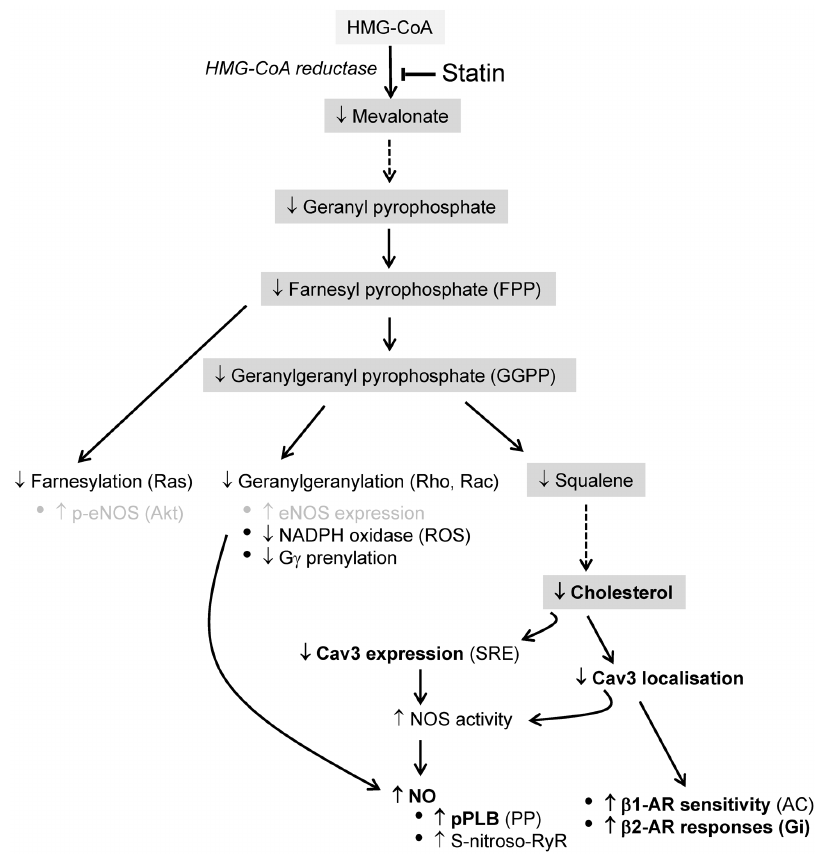
Figure 10. Statin effects on the cardiac myocyte. The main cholesterol synthesis pathway is highlighted in grey. The impact of statin inhibition of HMG-CoA reductase, the rate limiting step of cholesterol synthesis, is shown. Statins limit production of cholesterol and isoprenoid intermediates (FPP, GGPP). The latter are responsible for post-translational modification of a number of proteins including those of the small G protein family (Ras, Rho, Rac). The potential roles of isoprenoid- and cholesterol-dependent changes in modulating cardiac myocyte function are listed. From the present study, bold text indicates established effects, whereas grey text denotes effects which have been eliminated. ROS reactive oxygen species (which reduce bioavailable NO); PP phosphatase; AC adenylyl cyclase. See Discussion for detailed mechanisms and